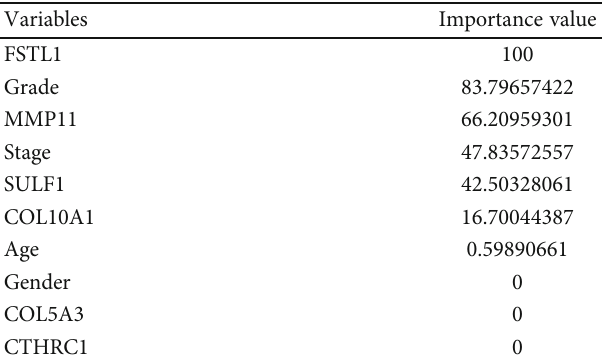
Table 1: The importance values in the GLM machine learning